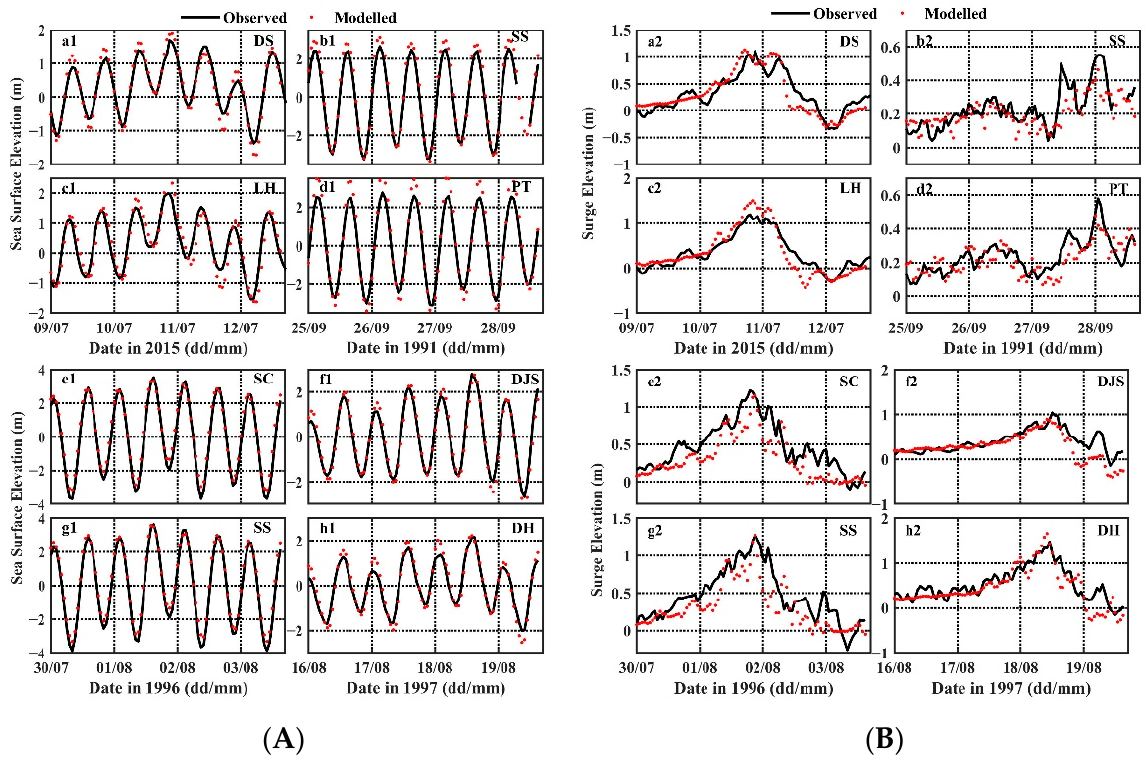
Figure 4. Time series of observed and modeled sea surface elevation (Panel A ) and surge elevation (Panel B ) during four typhoons (Typhoon: Chan-hom, Mireille, Herb, Winnie).